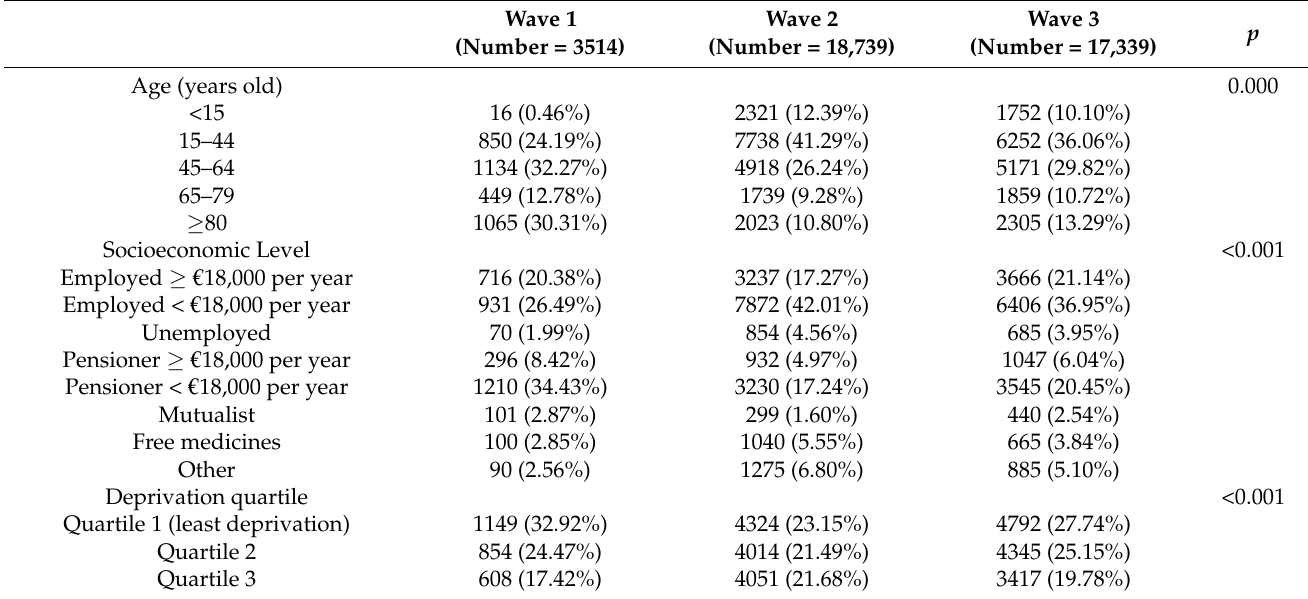
Table 1. Sociodemographic and morbidity description of confirmed COVID-19 women. Differences by